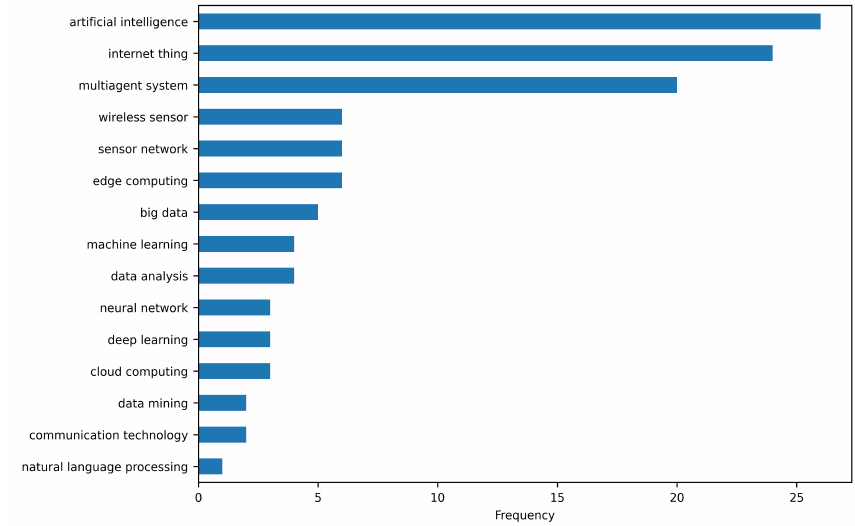
Figure 6. Enabling technologies for collective